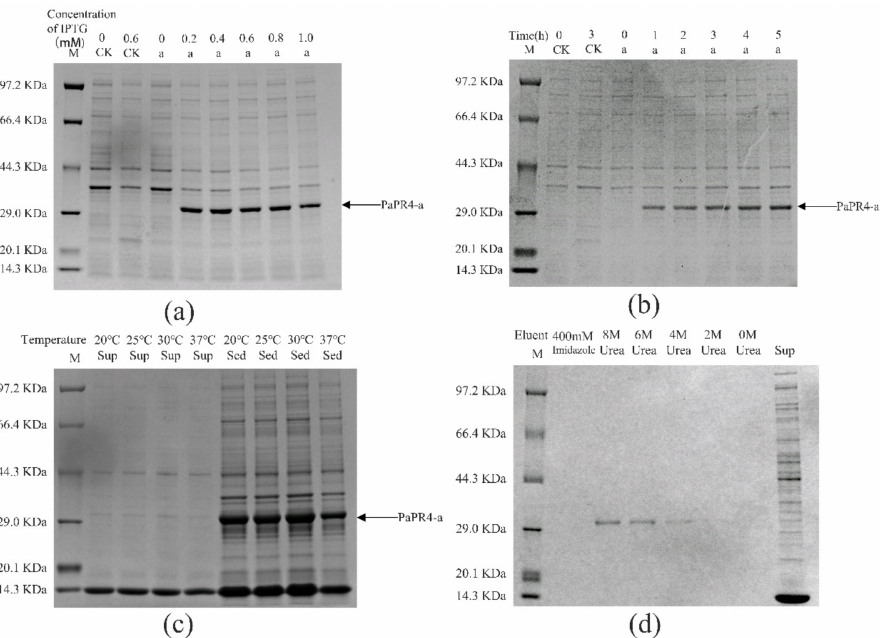
Figure 4. Analysis of the recombinant PaPR4-a protein with SDS-PAGE. M: Protein marker. CK: pET-32a vector expressed in E. coli BL21 (DE3) cells. Sup: supernatant. Sed: sediment. ( a ) The recombinant PaPR4-a protein was induced to express at 0, 0.2, 0.4, 0.6, 0.8 and 1.0 mM concentrations of IPTG. ( b ) Expression levels of the recombinant PaPR4-a protein at 0, 1, 2, 3, 4 and 5 h. ( c ) Induction of expression and detection of solubility of the recombinant PaPR4-a protein at 20 ◦ C, 25 ◦ C, 30 ◦ C and 37 ◦ C. ( d ) Renaturation and purification of the recombinant PaPR4-a protein.